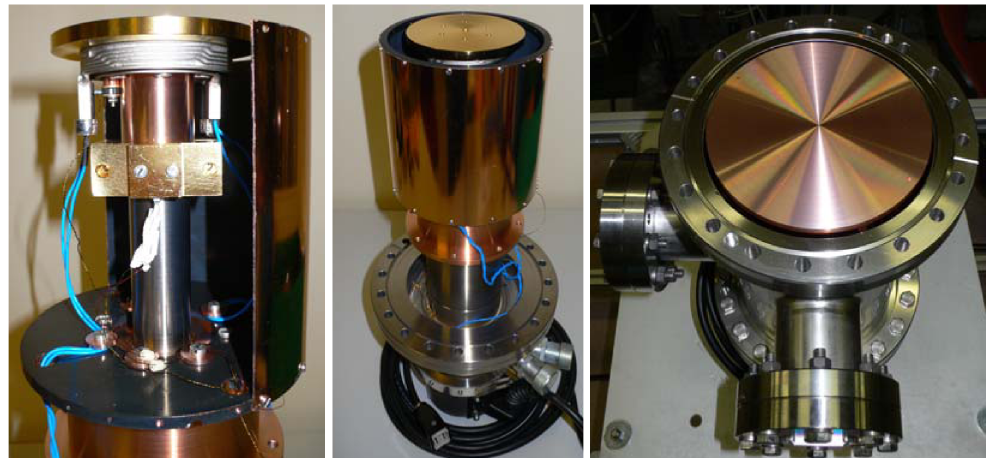
FIG. 1. Pictures of the new LINAC 3 cold-target assembly used for heavy-ion-induced desorption experiments of cryogenic surfaces. Left: cold-head with mounted heaters, temperature sensors, and partly installed thermal radiation shield (copper). Middle: cold-head with closed radiation shield. Right: assembly with mounted bare copper target integrated in a stainless steel vacuum chamber housing instrumentation